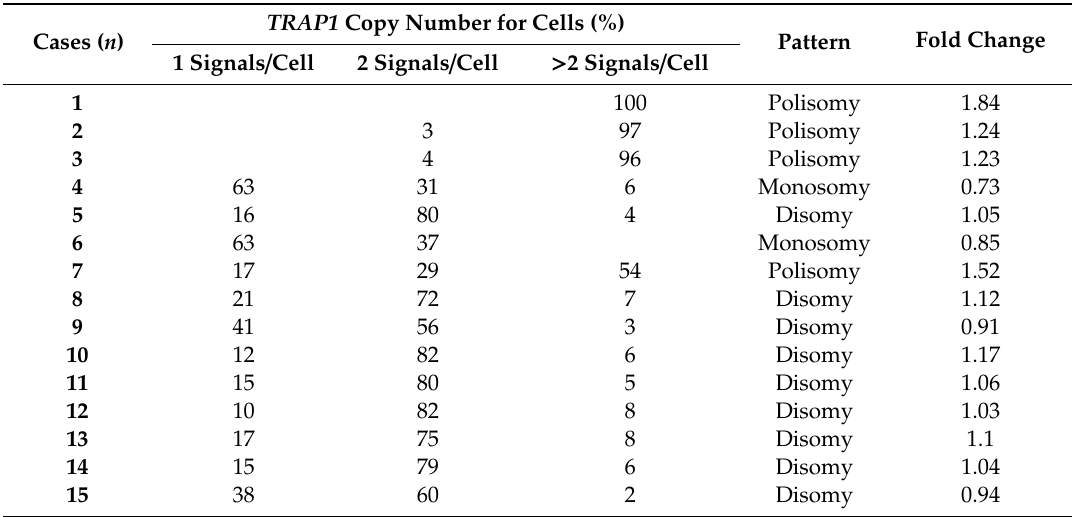
Table 2. Comparative fluorescent in situ hybridization (FISH) and RT-PCR analysis of TRAP1 gene CN. Cases ( n )